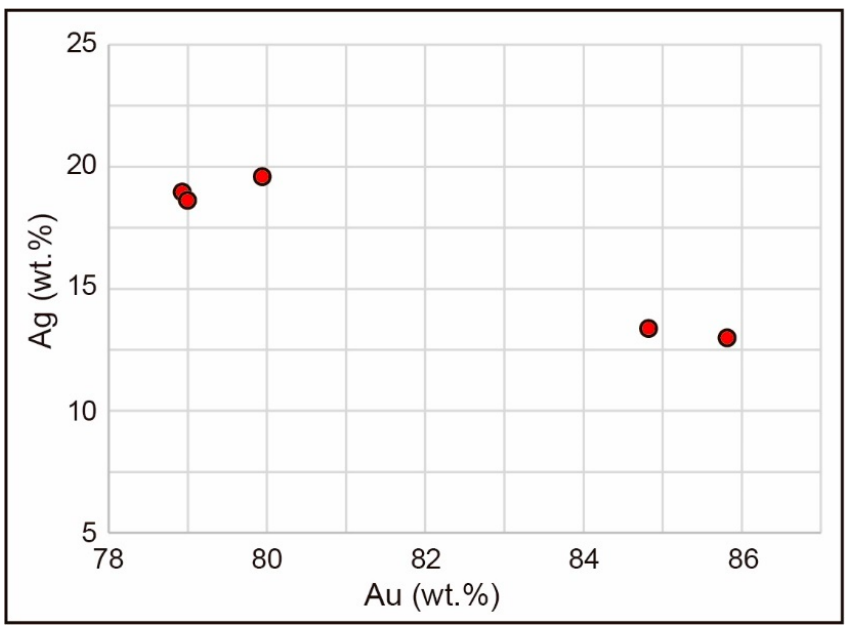
Figure 4. Electron probe microanalyses (EPMA) of gold grains in association with pyrite 2a, pyrite 2b, chalcopyrite, and aikinite. The full EPMA dataset is presented in Supplementary Material B (Table S1). Due to the suspicion of invisible gold in pyrite 2a (visible gold was only associated with Pyrite 2b), LA-ICP-MS analyses were performed on most sulphide minerals from the gold-bearing assemblage in order to identify potential gold carriers (Supplementary Material C: Table S2). These analyses confirm the presence of invisible gold in pyrites 2a and 2b (Figure 5A,B). The low As and the low Au contents in the two generations of pyrite indicate the presence of chemisorbed invisible gold fixed in structural defects of the pyrite structure (Figure 5B; [50]). Both pyrite generations show similar trace element signatures, including As and Au, and thus geochemically cannot be well differentiated (Figure 5A,B). In the studied pyrite generations, Au correlates positively with Ag (Figure 5C), but in a ratio of 1:10, thus excluding the possibility of incorporating gold as sub-micron inclusions with similar composition as the visible gold in the